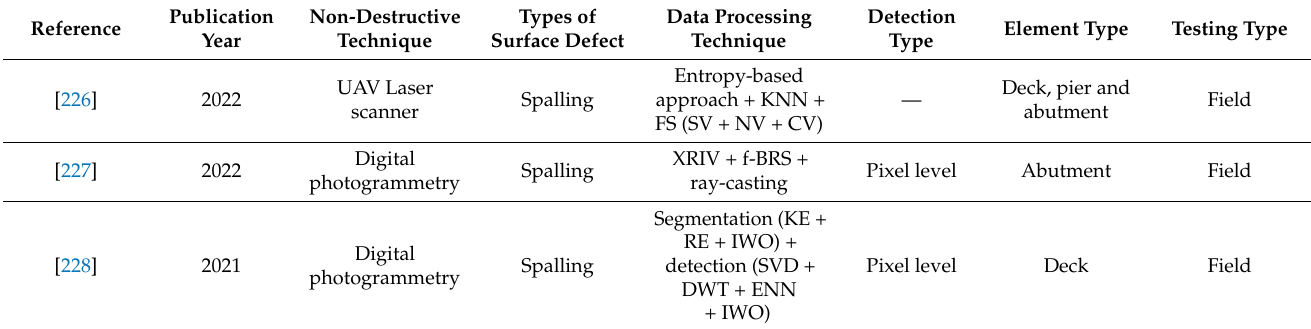
Table 18. Summary of some of the research studies for detection of spalling and